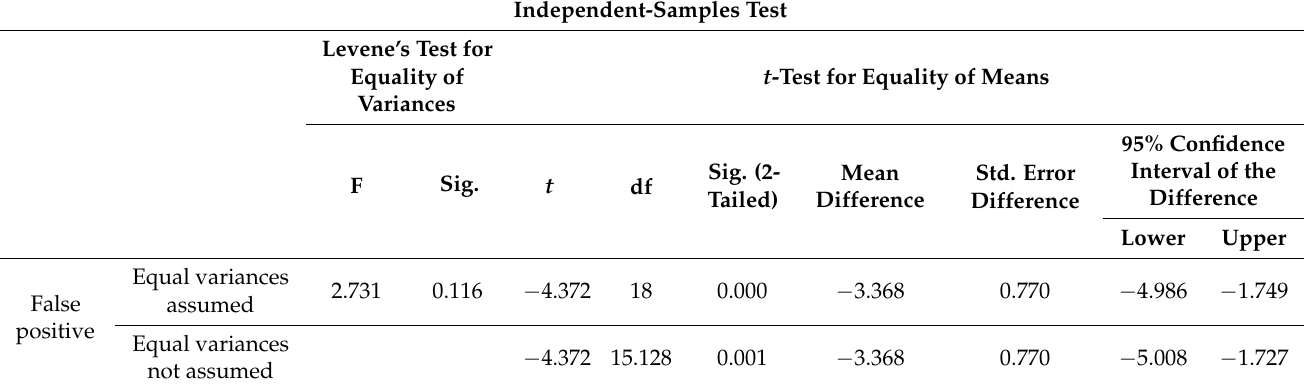
Table 9. Independent-sample test significance computation between ECNN and CNN algorithms for false positive.